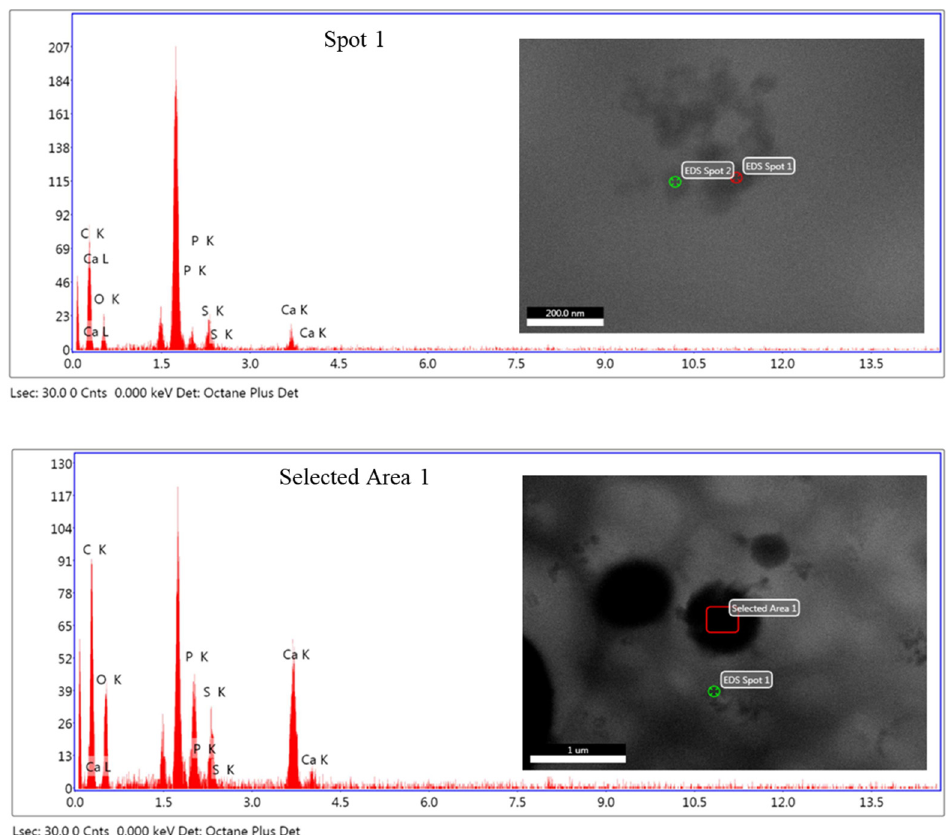
Figure 4. X-ray spectra were taken from a large aggregate ( top ) and an agglomerate ( bottom ).